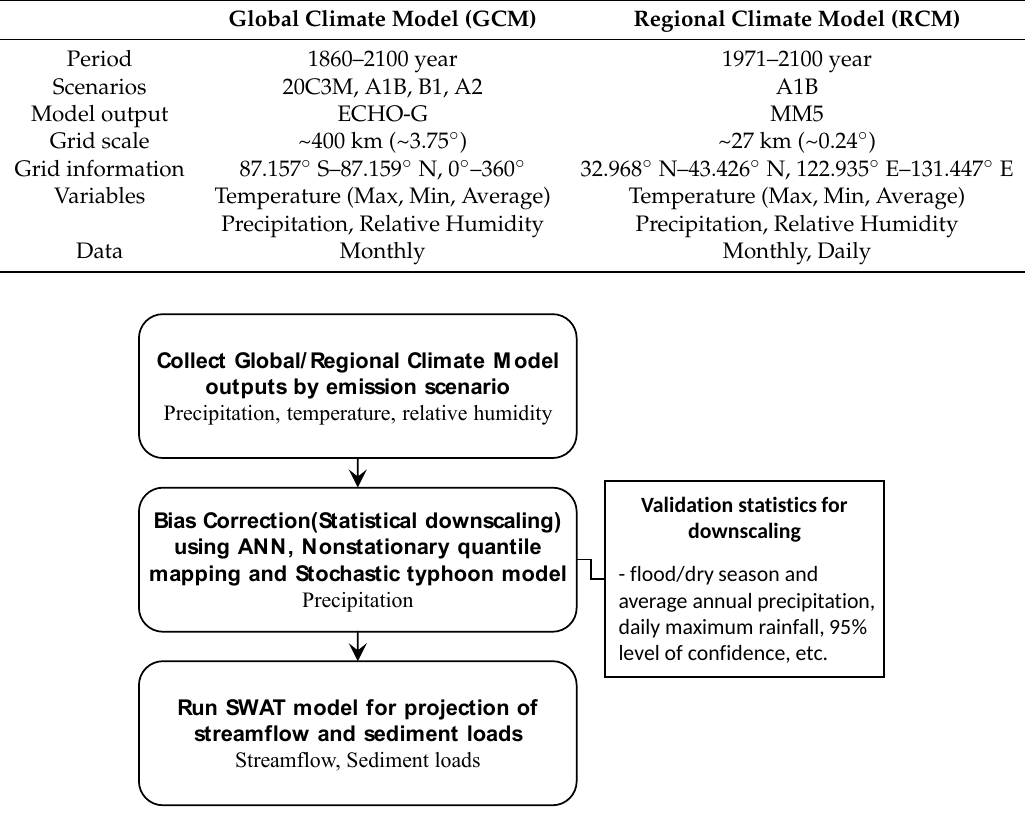
Table 1. Specific information for the global and regional climate model provided by KMA.